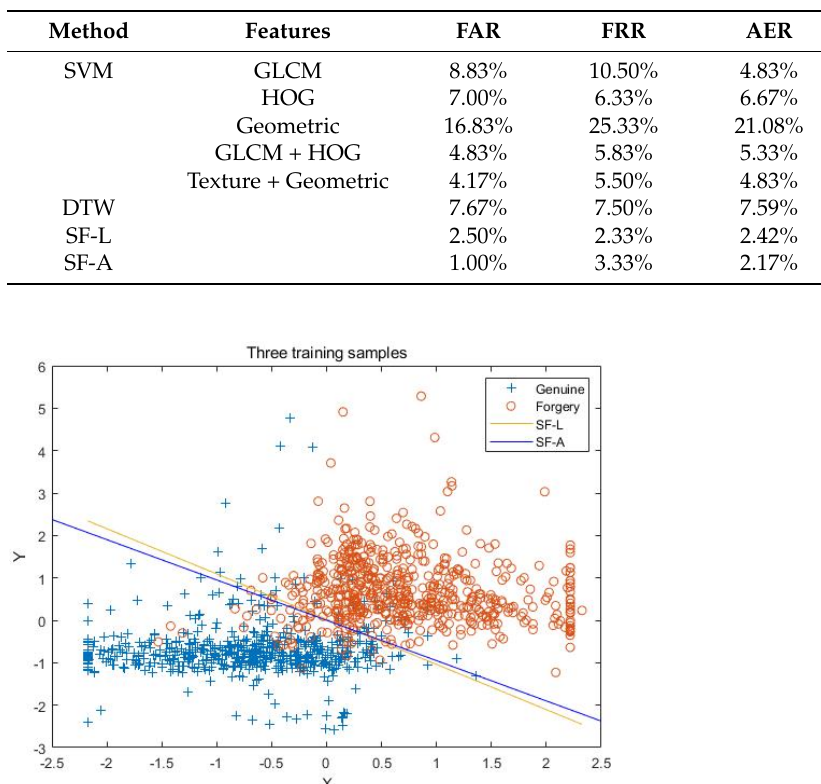
Table 7. The result of ten training samples. Table 4. The result of three training samples.